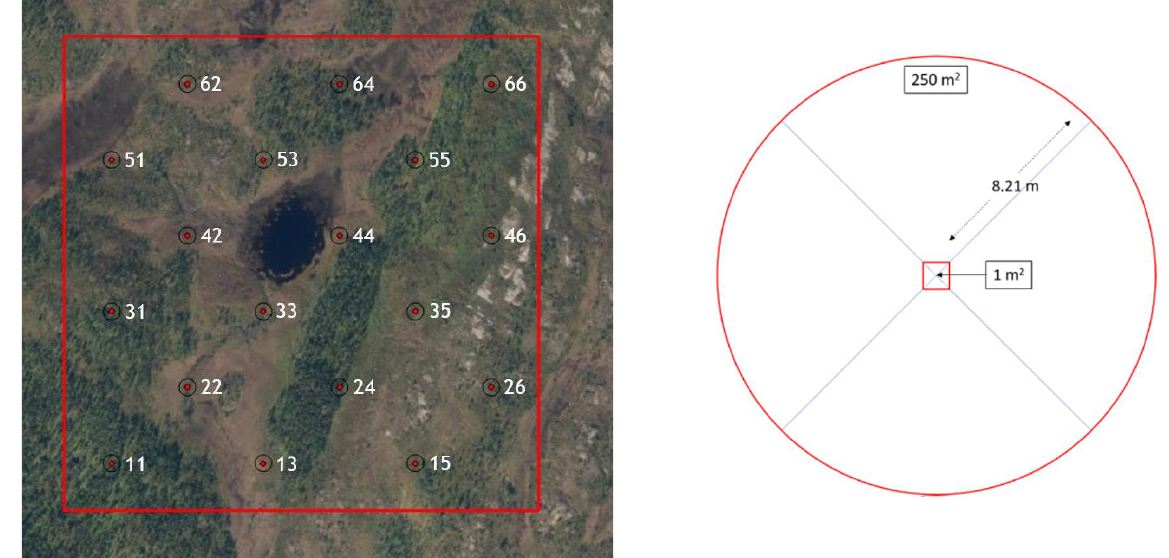
Figure 3. Field design of the unseen validation dataset named as the area representative for monitoring in Norway (ANO), first established in 2019. To the left is an example of a 500 × 500 m square that contains 18 monitoring circles in a systematically positioned geographical system. To the right is an example of a 250 m 2 monitoring circle with a vegetation sample plot of 1 m 2 in the middle. The main dominating LULC class (percent cover) is allocated to the circle in the field, while both the main LULC class and species estimates are given to the 1 m 2